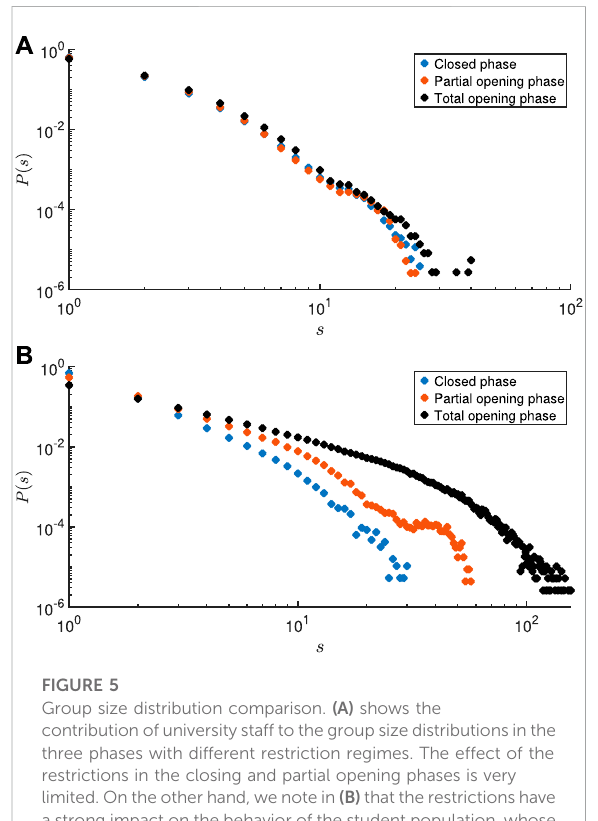
Group size distribution comparison. (A) shows the contribution ofuniversitystaff to thegroup sizedistributions inthe three phases with different restriction regimes. The effect of the restrictions in the closing and partial opening phases is very limited. Ontheotherhand, wenotein (B) that therestrictionshave a strong impact on the behavior of the student population, whose group size distribution is strongly modi fi ed in the different